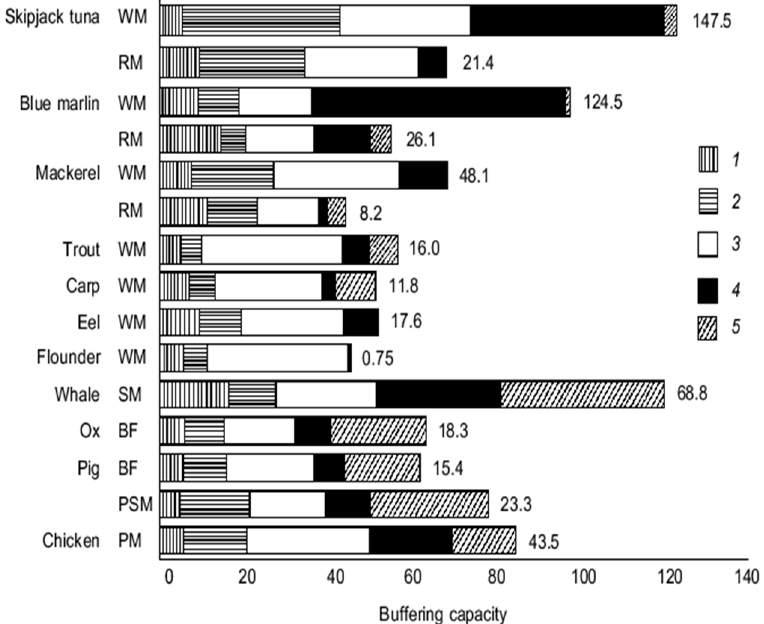
Figure 2. Muscle histidine and histidine-related compounds buffering contribution (4) in comparison with proteins among species (contractile (1) and soluble (2)), inorganic orthophosphate (3), and unknown compounds (5)). Buffering capacity is expressed as µmol NaOH per pH unit per g muscle over pH 6.5–7.5. Values indicated on the bars represent the concentration of total histidine-related compounds (µmol/g muscle). WM, white muscle; RM, red muscle; SM, skeletal muscle; BF, biceps femoris ; PSM, psoas muscle; PM, pectoralis minor [29].